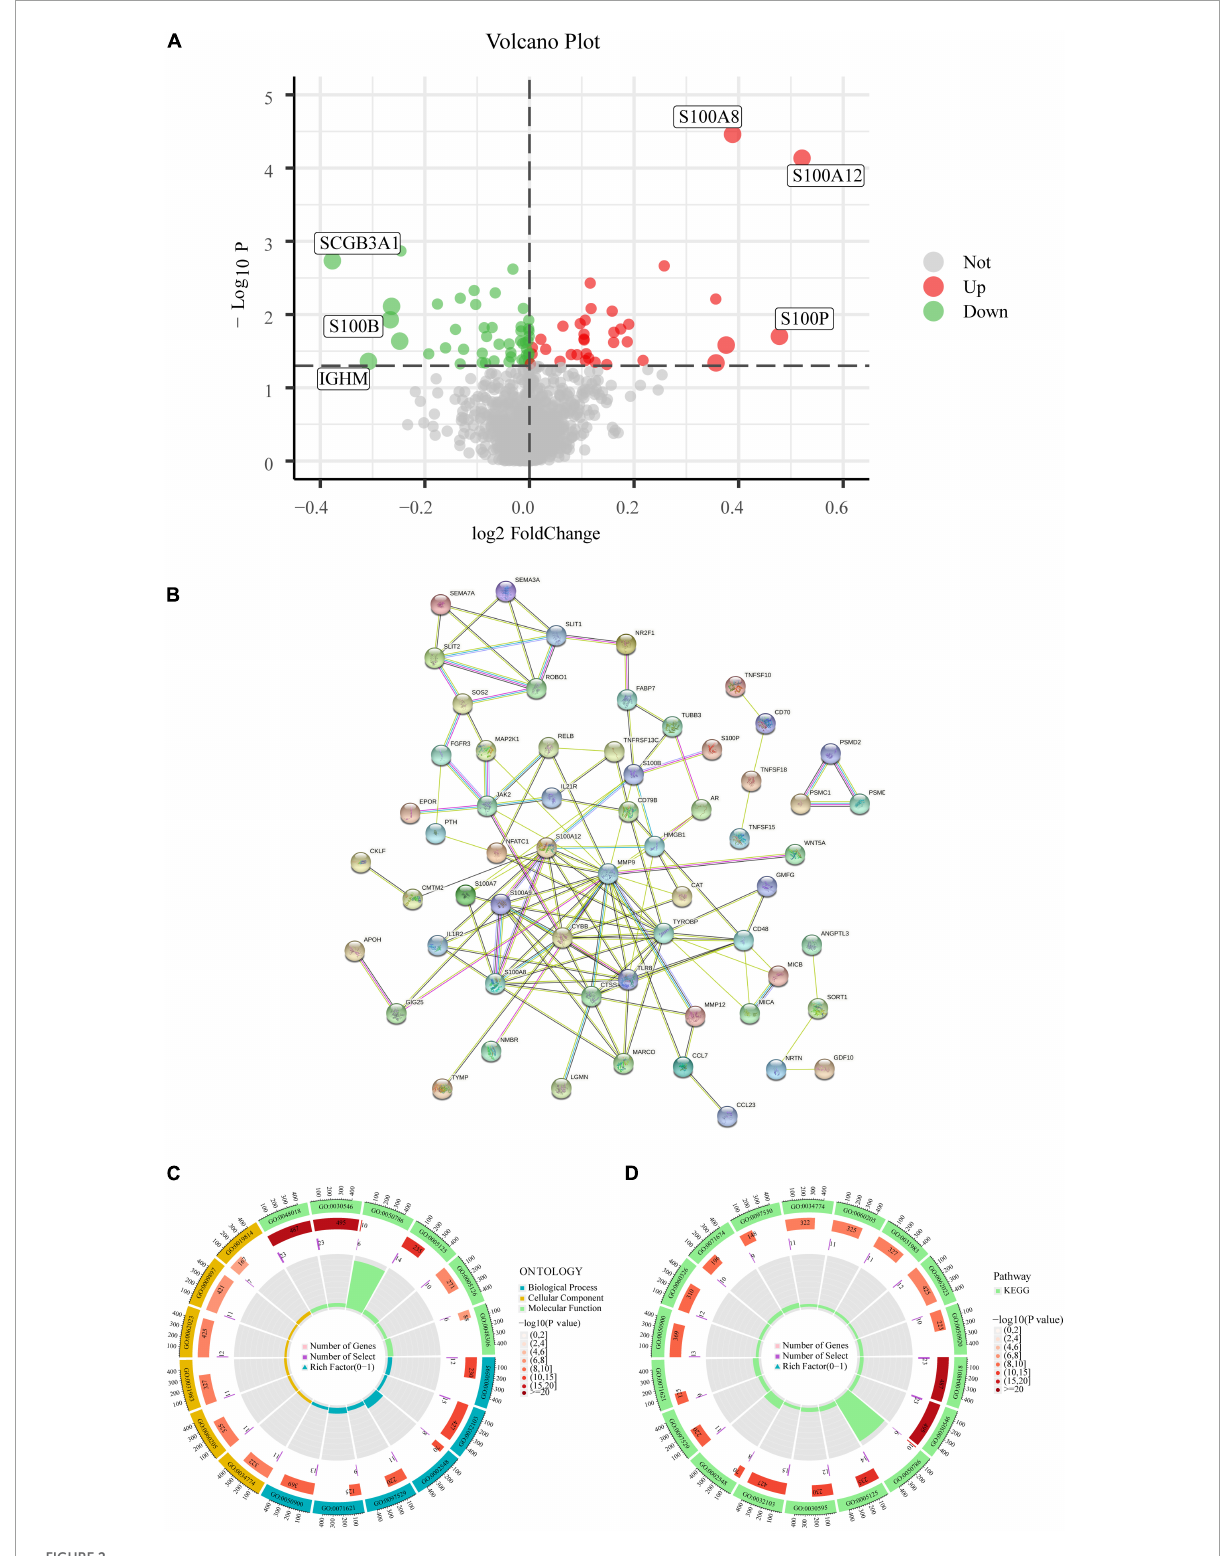
FIGURE2 Analysis of DE-IRGs. (A) Volcano plot of the DE-IRGs in CAD. (B) PPI network. (C) GO enrichment analysis. (D) KEGG enrichment